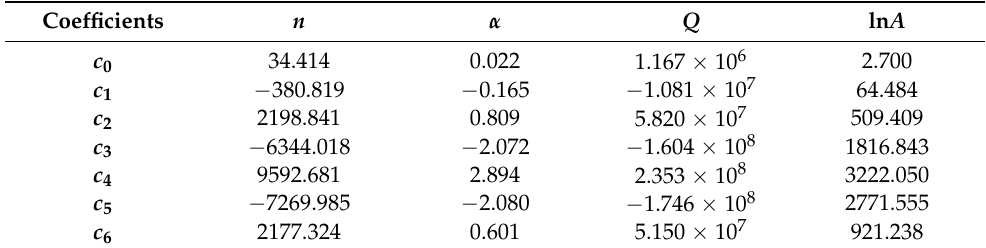
Table 2. Coefficients of the polynomials.